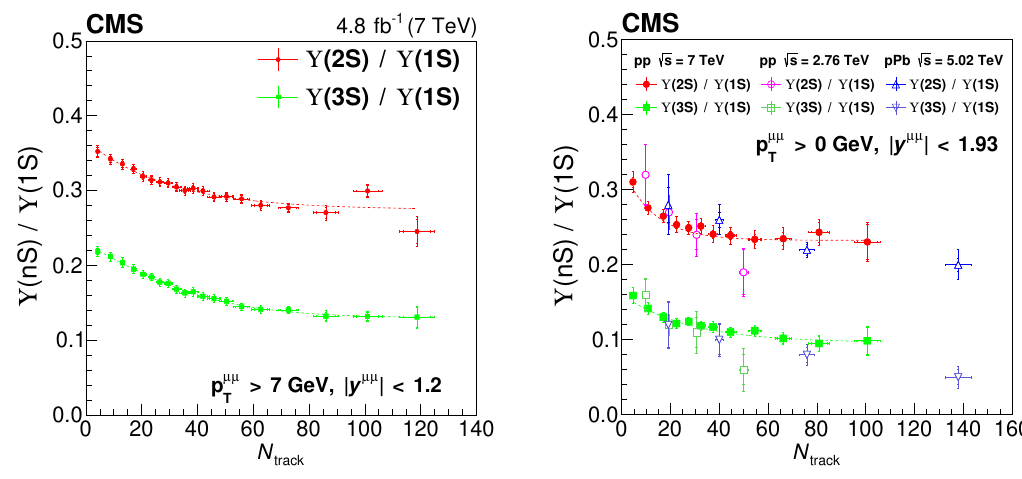
Figure 2 . The ratios (cid:7) (2S) = (cid:7) (1S) and (cid:7) (3S) = (cid:7) (1S) with p (cid:22)(cid:22) > 7 GeV (left) and p (cid:22)(cid:22) > 0 GeV T T (right) as a function of N . The lines are (cid:12)ts to the data with an exponential function. The track outer vertical bars represent the combined statistical and systematic uncertainties in the ratios, (cid:10) (cid:11) while the horizontal bars give the uncertainty in N in each bin. Inner tick marks show only track (cid:10) (cid:11) the statistical uncertainty, both in the ratio and in N . The results of ref. [7] are shown in the track right plot for comparison, and a small correction is applied to the present results to account for the di(cid:11)erent rapidity ranges in the measurements, j y (cid:22)(cid:22) j < 1 : 20 here and j y (cid:22)(cid:22) j < 1 : 93 in ref.